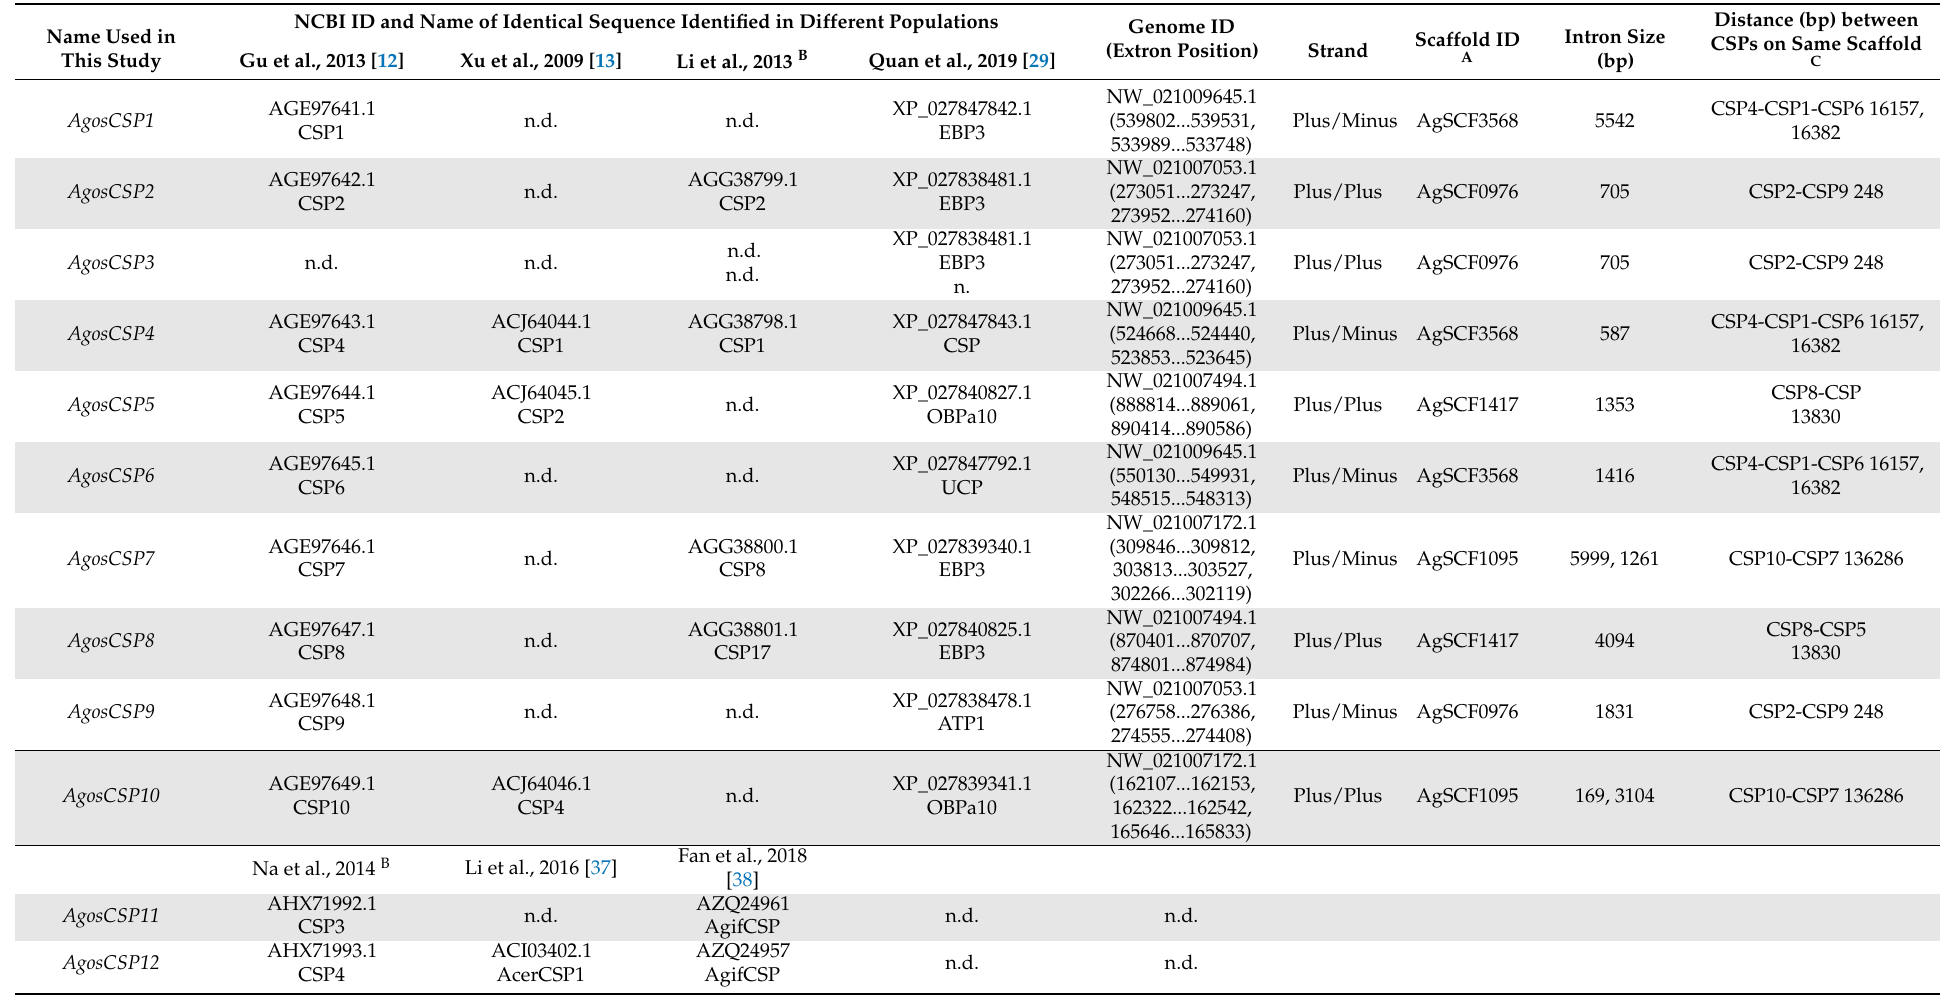
Table 1. Annotation and comparison of chemosensory proteins of the cotton aphid identified from different